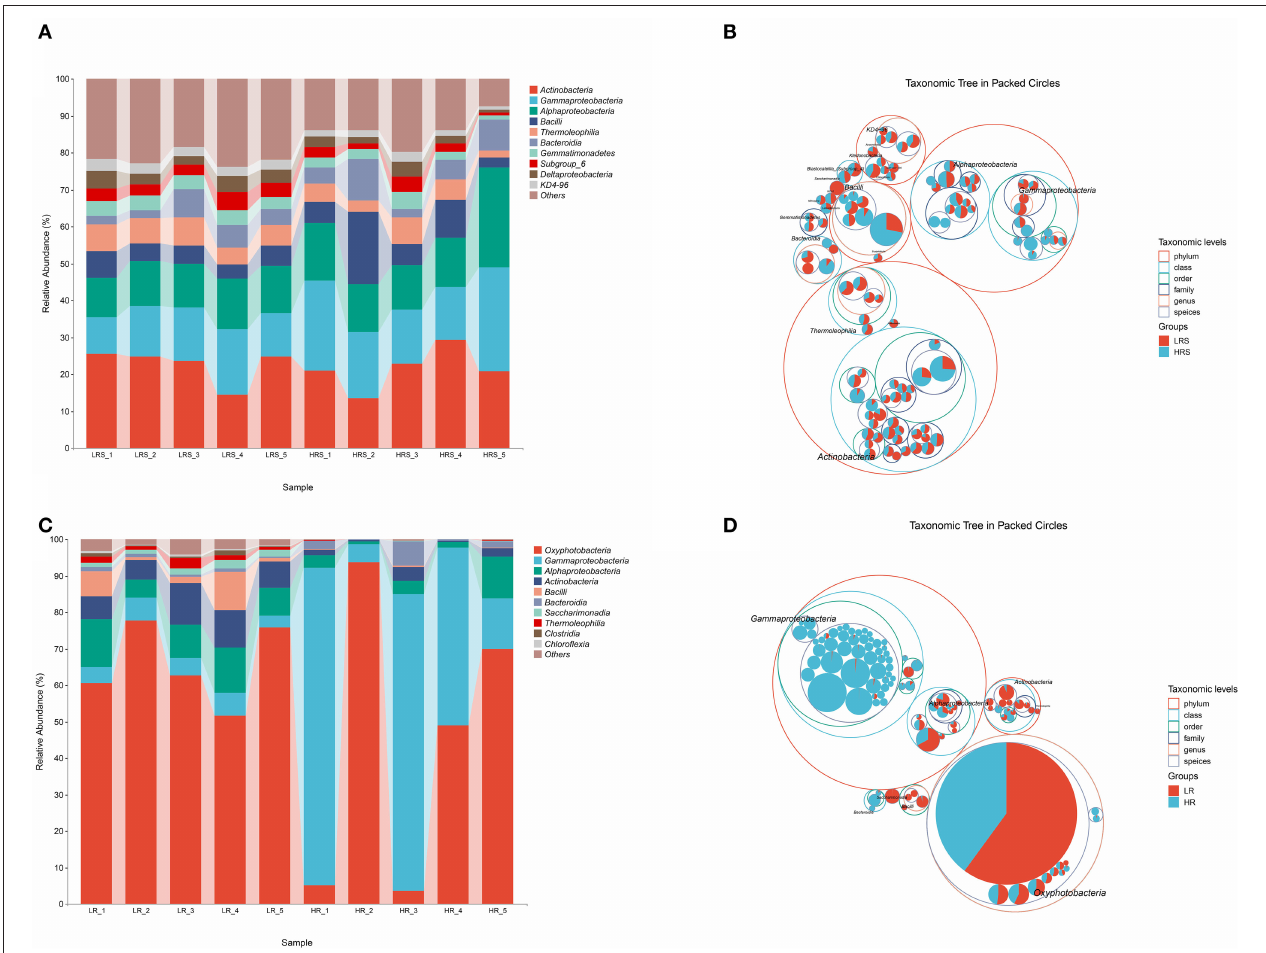
FIGURE 2 | The bacteria community composition in the LR and HR soil–root system. (A,B) The relative abundance of classes (A) and the taxonomic difference (B) between the LR and HR soil. (C,D) The relative abundance of classes (C) and the taxonomic difference (D) between the LR and HR cabbage roots. The largest circle represents the phylum level, and the inter circles represent class, family, and